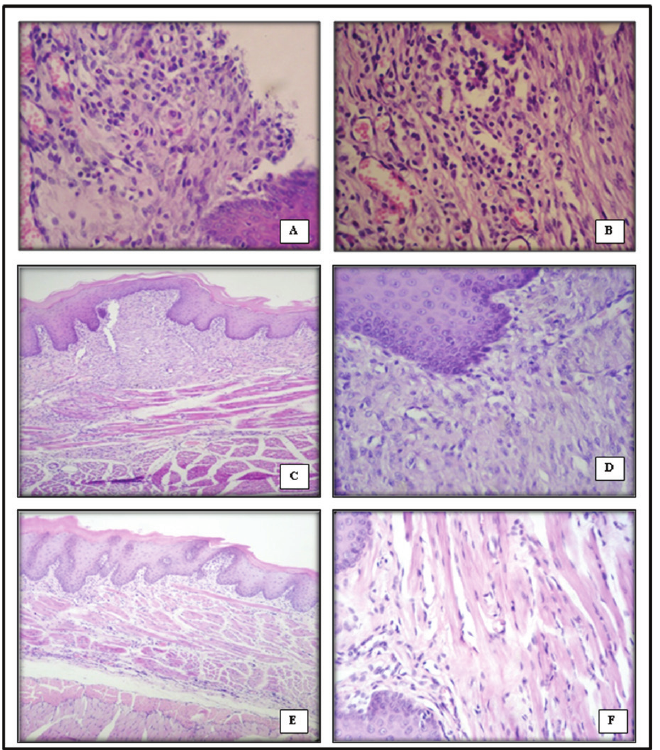
FIGURE 7 - Photomicrograph of histological sections from the days 5-10 of evolution ( A ). Persistence of the ulcer (arrow) and ( B ) presence of mononuclear cells and dilated vessels on day 5 after ulceration (HE, 400X). ( C ) Absence of ulcer and fibrosis (HE, 200X). ( D ) Presence of discreet chronic inflammatory infiltrate (HE, 400X). ( E ) Absence of ulcer and remodeling of the collagen fibers (HE, 200X). ( F ) Remodeling of collagen fibers (HE, 400X).